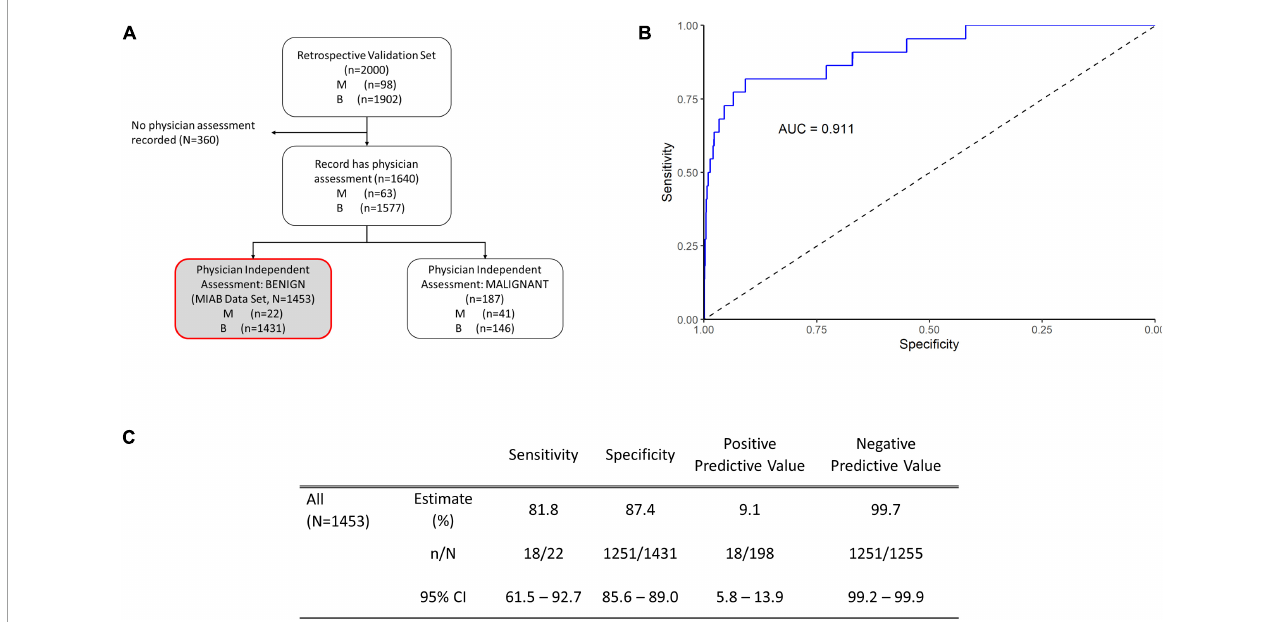
FIGURE3 Performance of OVAWatch in the multivariate index assay benign (MIAB) data set. (A) Flow diagram showing patient data represented (shaded, with red outline). (B) Receiver-Operator Characteristics (ROC) plot of the MIAB data set. The area under the ROC curve (AUC) for OVAWatch was 0.911.